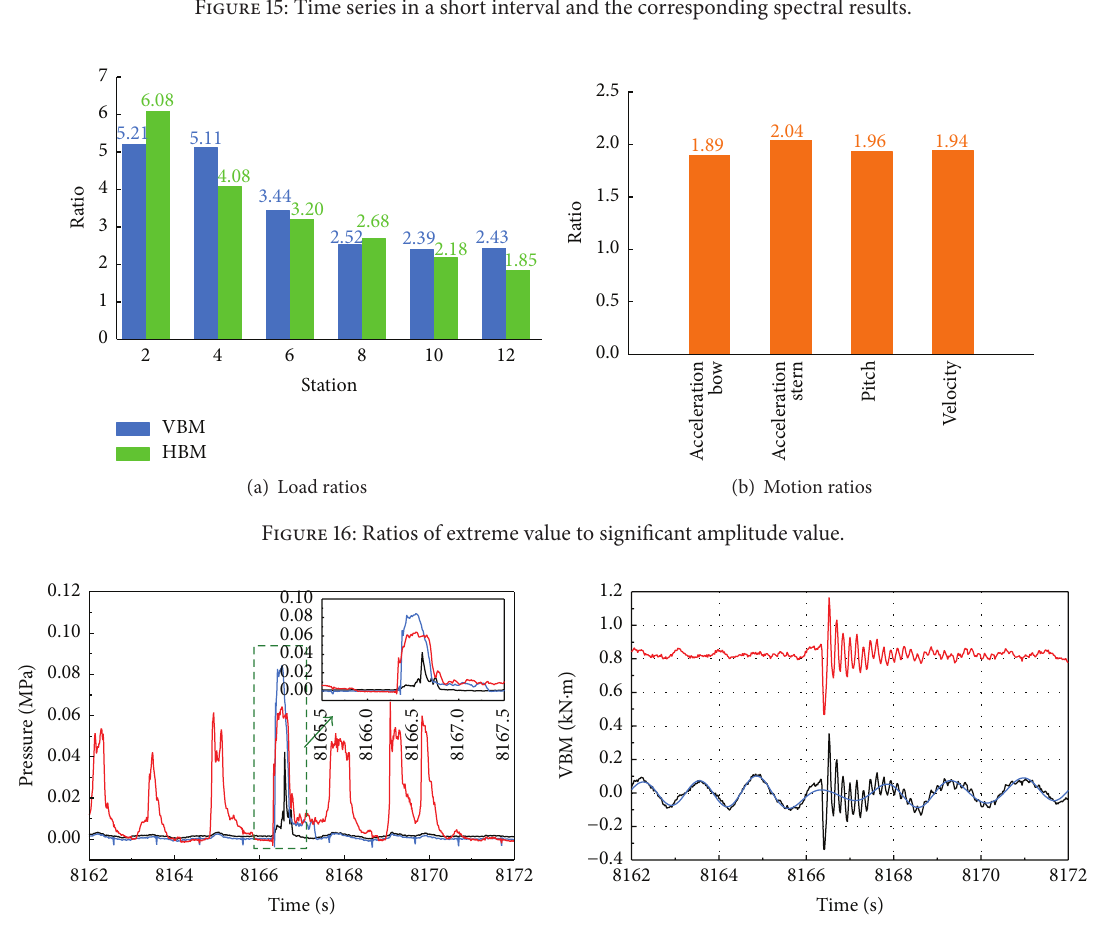
indicates that the largest slamming pressure occurred at around the position of gauge 2 for this slamming